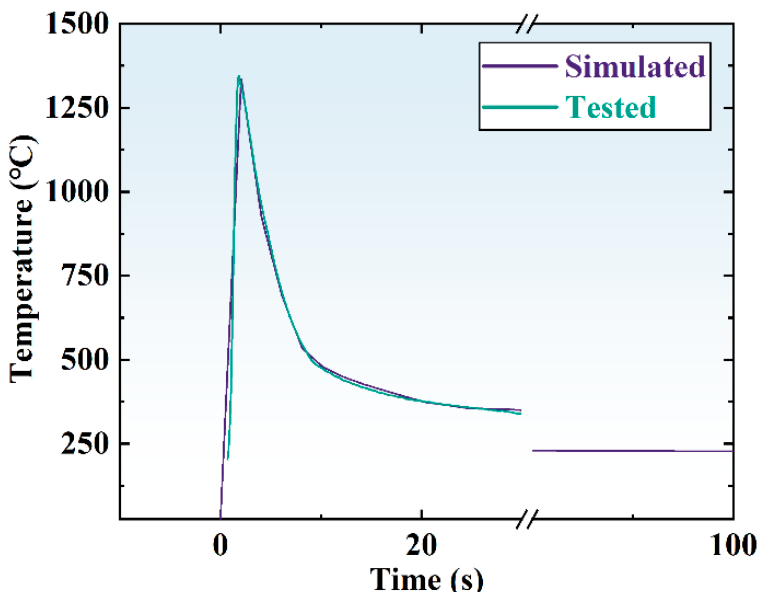
Figure 4. Meshed model used in the simulation.